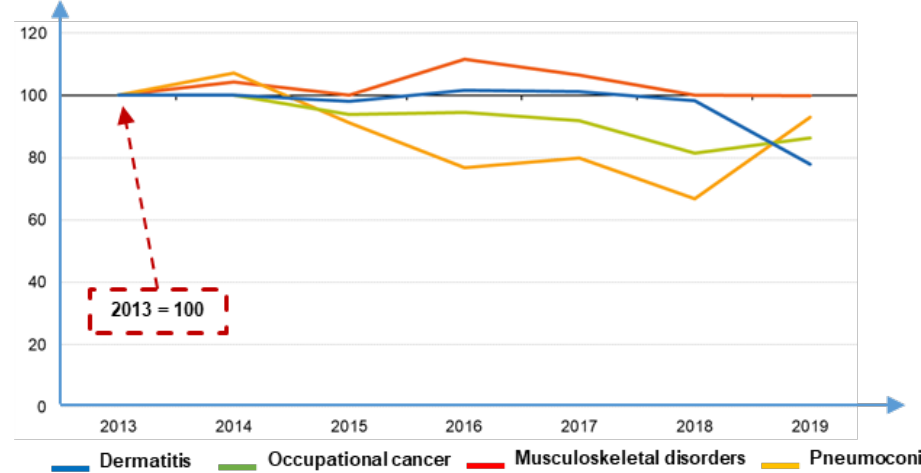
Figure 1. Musculoskeletal diseases statistics (elaborated from [5]).